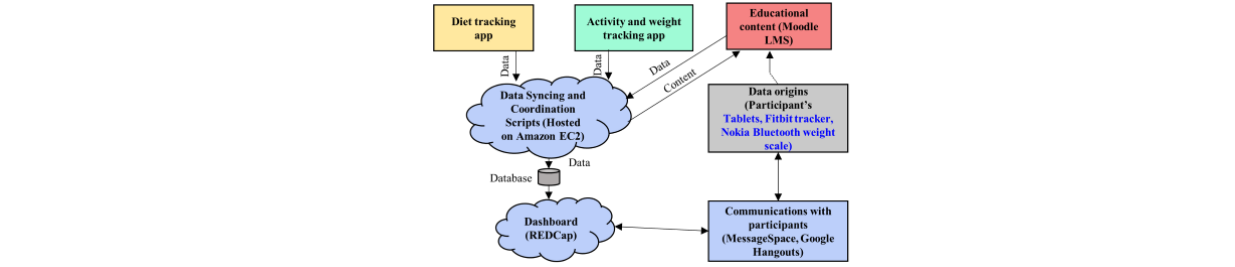
Figure 4. Healthy Frio remote technology intervention system architecture. EC2, Elastic Cloud Compute; LMS, learning management system; REDCap, Research Electronic Data